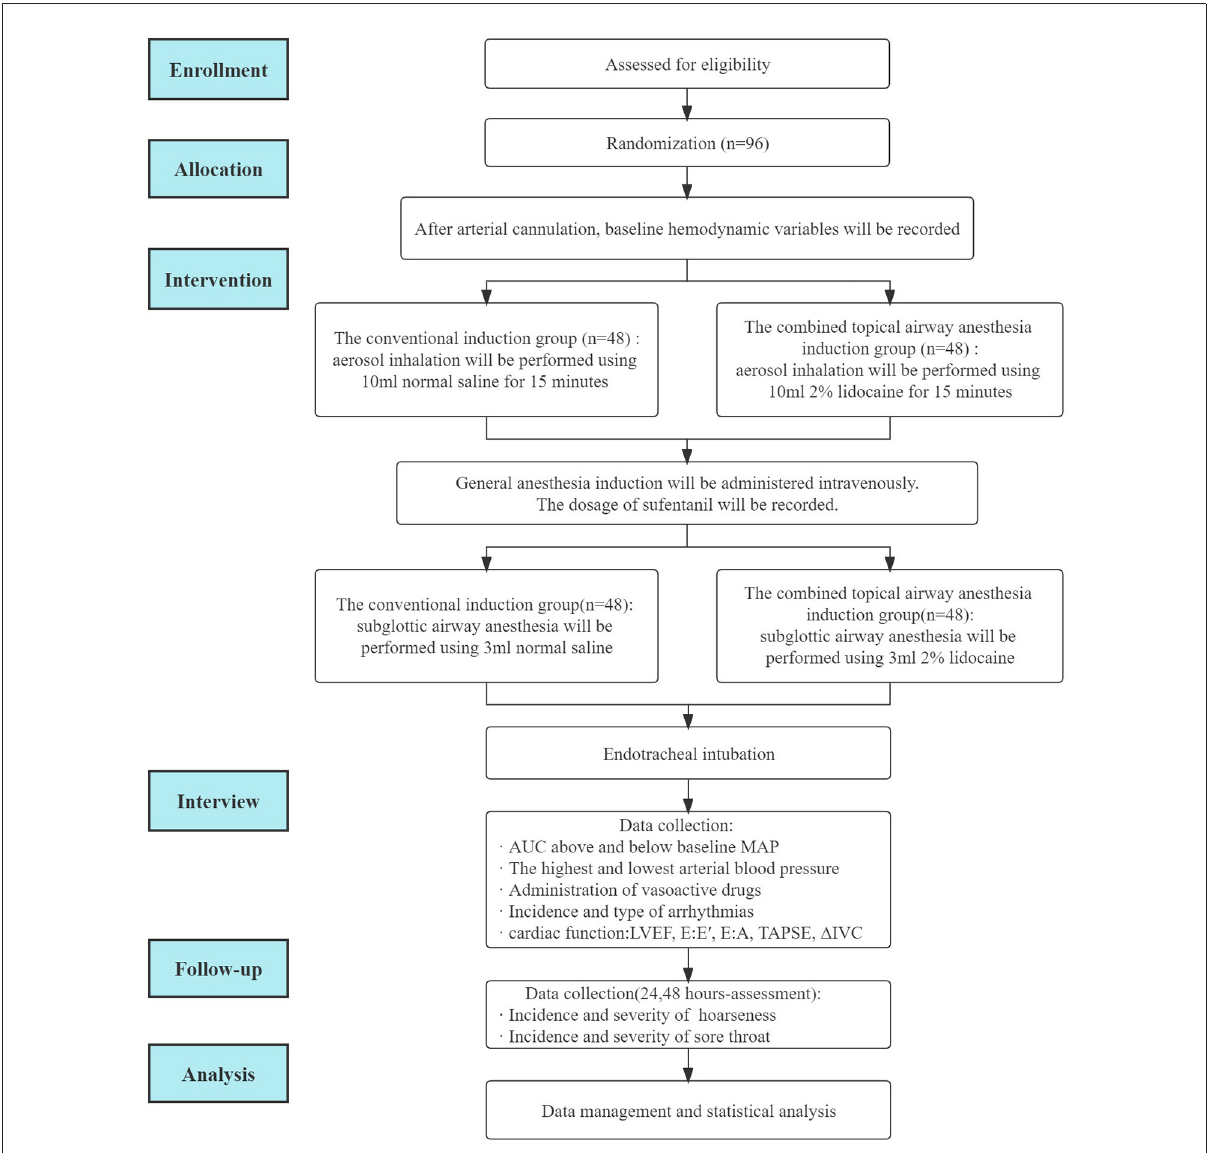
FIGURE1 Flowchart of the clinical trial